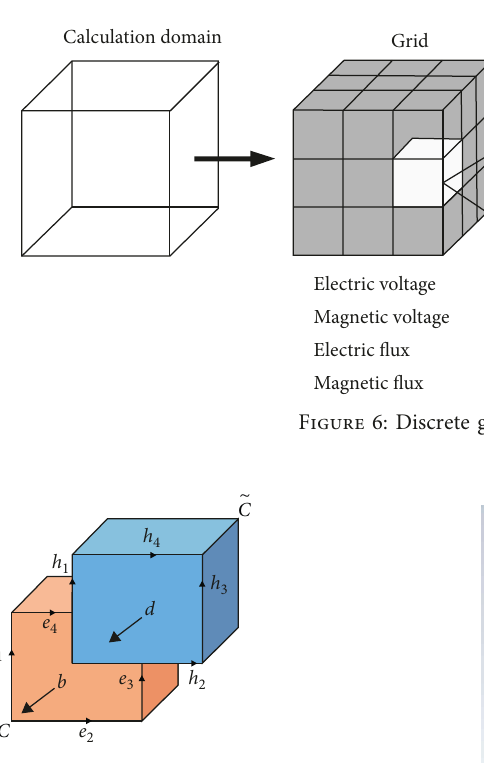
Figure 7: Allocation of the voltage and flux components in the